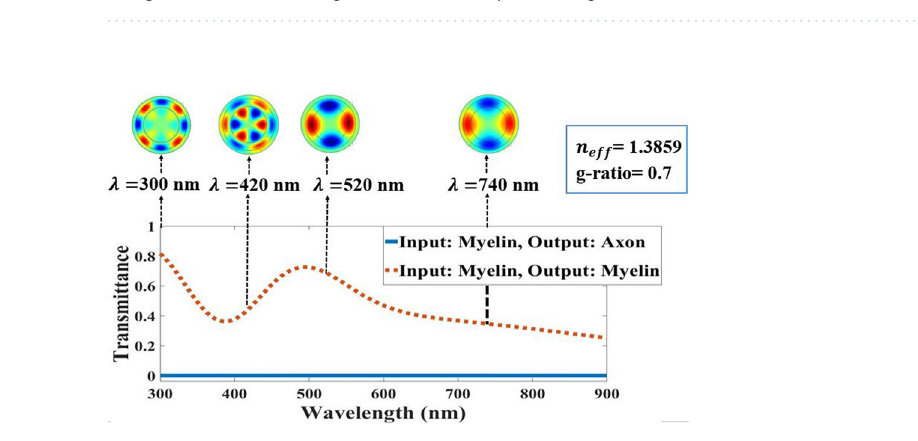
Table 2. Orders of magnitude transmitting for typical wavelengths in g-ratio = 0.7 and g-ratio = 0.6 compared to a g-ratio = 0.78 when light launched to Myelin in Fig. 5a.